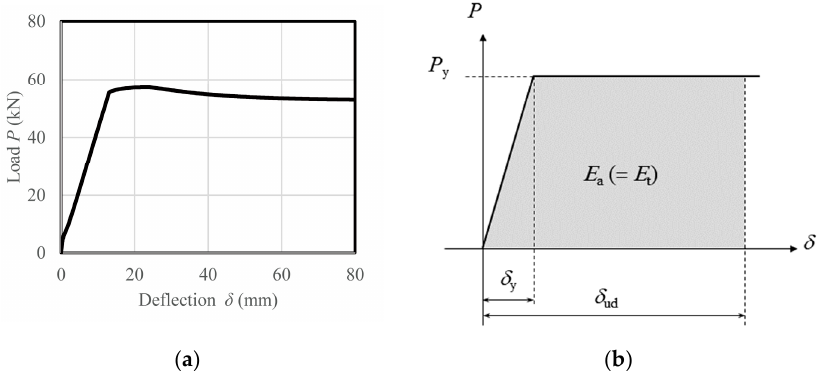
Figure 13. Simplified load ( P )–deflection ( δ ) relation of the RC beam; ( a ) Calculated P – δ relation (reprint of Figure 3), ( b ) Simplified P – δ relation.